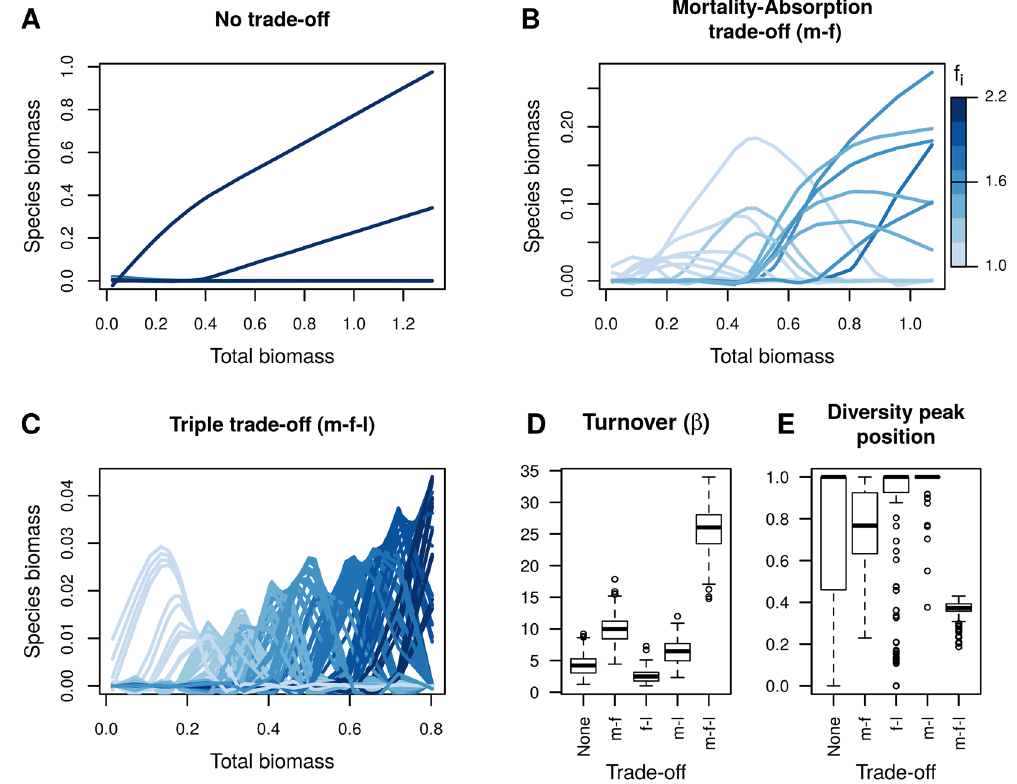
Figure 1. Influence of trade-offs on community turnover along a resource gradient represented by total community biomass. ( A – C ) Single species biomass along the gradient total community biomass; the different figures represent species pools with a different set of trade-offs among traits. The shades of blue represent the values of species f i with light blue representing low values of f i * and dark blue representing high values of f i * . Other possible trade-offs (mortality–biomass tolerance, resource absorption–biomass tolerance) are displayed in the supplementary material. ( D ) turnover ( β -diversity) along resource gradients as a function of the trade- offs. Parameters used to generate this figure were: N = 125, b = 0.5, average of f i = 1.6, variability of f i = 1.2, average of l i = 2.05, variability of l i = 1.7, c i = 0.6, B = 0.5. Distributions of species traits along the trade-off axes were kept uniform. The assembly of 800 different species pools were simulated to generate this